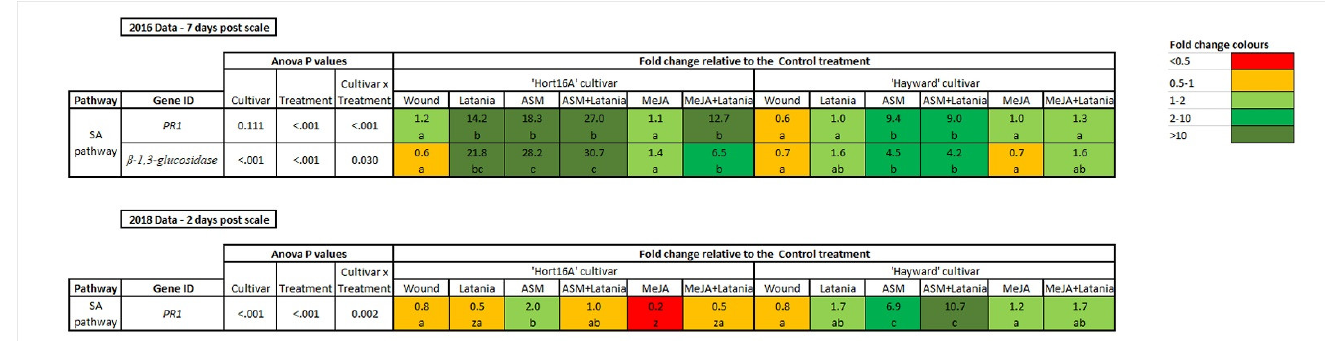
Figure 4. Relative defence gene expression as measured by quantitative polymerase chain reaction (qPCR) in ‘Hort16A’ and ‘Hayward’ kiwifruit leaf tissue in 2016 and 2018. Leaves were left unsprayed or were treated with 0.2 g/L Actigard™ (ASM) or with 0.05% v / v methyl jasmonate (MeJA) to elicit the salicylic acid (SA) and jasmonic acid pathways, respectively. Seven days later, latania scale crawlers (approximately 200/leaf) were applied, or leaf wounding (to imitate scale feeding) was carried out using a fine needle. Control plants were left untreated. Leaf sampling for gene expression analysis took place seven days post scale infestation (psi) in 2016 and at two and seven days in 2018. There were five replicate plants per treatment. Fold change data relative to the control treatment are presented, where orange/red colours represent a decrease in gene expression, whilst green shades indicate up-regulation relative to the control. Fold changes in the order of 0.5–2 are not considered biologically significant [13–15]. Statistical analysis necessitated a log 2 transformation, but data are presented as back-transformed means ± standard errors. P-values are from ANOVA, and only data with a significant Cultivar × Treatment interaction are presented. Different lettering indicates statistically significant treatment differences relative to the control treatment (designated the letter a), as shown by LSD ( p ≤ 0.05), with the letter z indicating significant down-regulation.